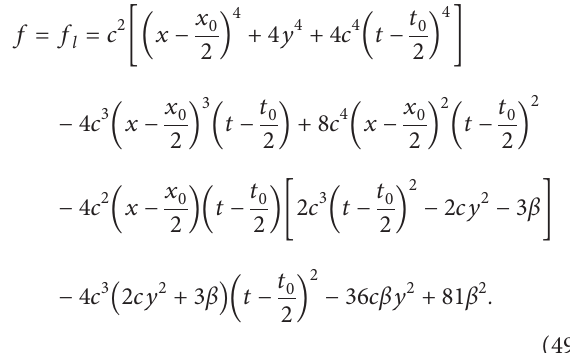
� b � 5, at time t � 1 2